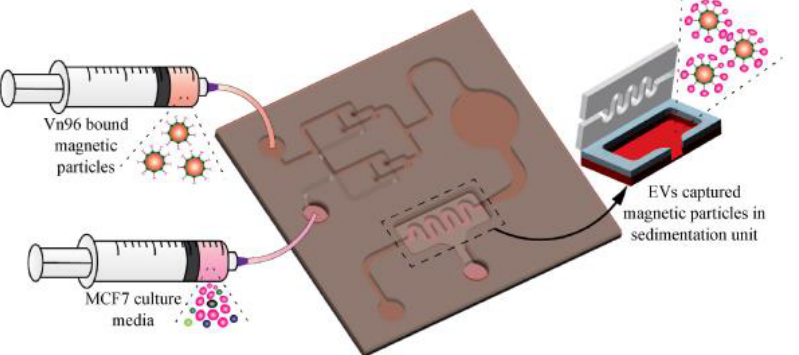
Figure 16. Isolation of EVs from the MCF7 CCM A) Schematic of the EV-isolation from the CCM in the microfluidic device. (Reproduced with permission from Bathini S. et al. [81]. Copyright 2021, Elsevier Science).